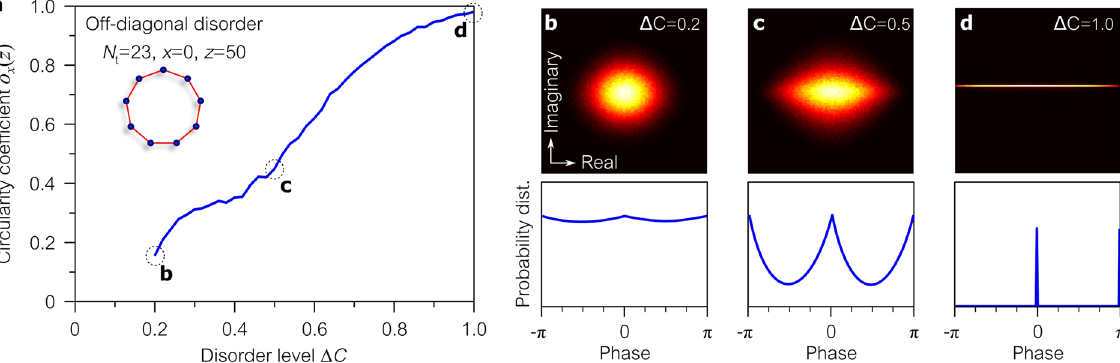
Figure 5. Circularity in odd-sited ring lattices with off-diagonal disorder. ( a ) Increasing the disorder level ∆ C reduces the circularity of the output field at the excitation waveguide ( = x 0 ) and increases the circularity coefficient o z ( ) . ( b – d ) The field probability distribution in the complex plane for selected disorder levels. Bright x colors represent higher probability density. The second row gives the probability distribution of the corresponding field